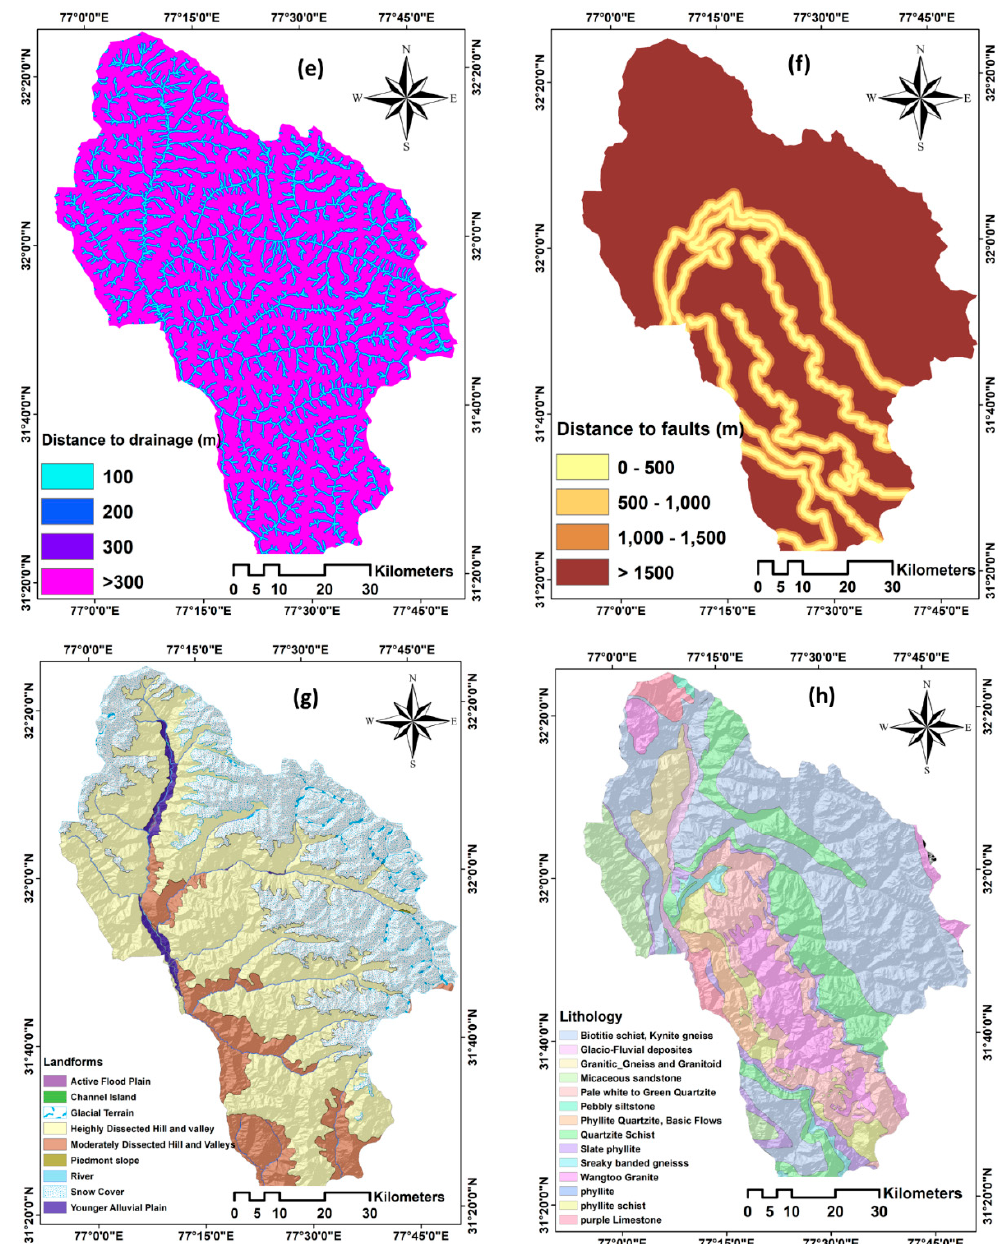
Figure 2. Thematic maps used in this study ( a ) elevation, ( b ) slope angle, ( c ) slope aspect, ( d ) roads, ( e ) drainage, ( f ) faults, ( g ) landforms, and ( h ) lithology. These landslide-conditioning factors were derived from 30 m ASTER DEM and fieldwork carried out in the study area.